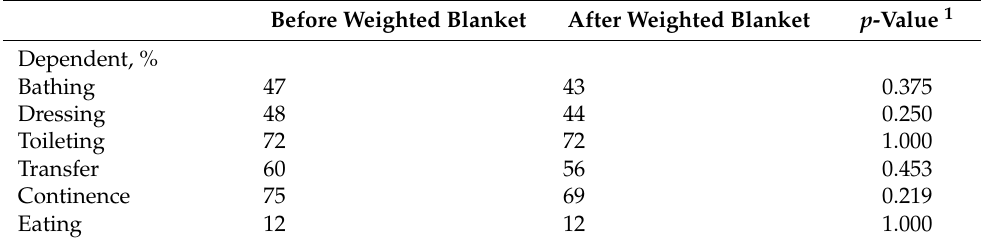
Table 4. Percentage movement in ADL dependent before and after utilisation of weighted blanket for 28 days, n = 68. Before Weighted Blanket After Weighted Blanket p -Value 1